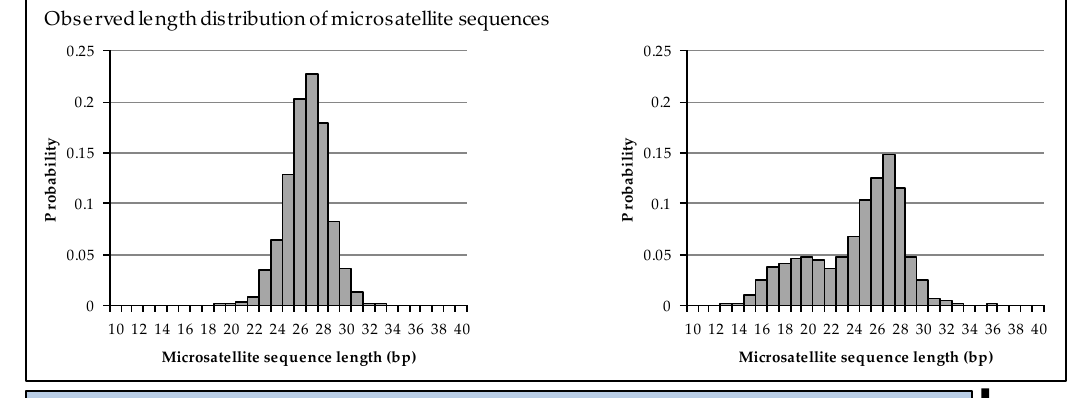
Modelling of the mixture model best fitted to the observed distribution, using EM algorithm